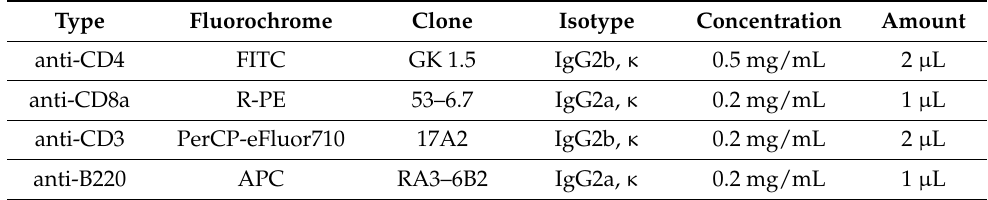
Table 2. The specifications of the anti-mouse monoclonal antibodies (eBioscience, San Diego, CA, USA) and amounts used for 50 µ L of blood or cell suspension from mesenteric lymph nodes.